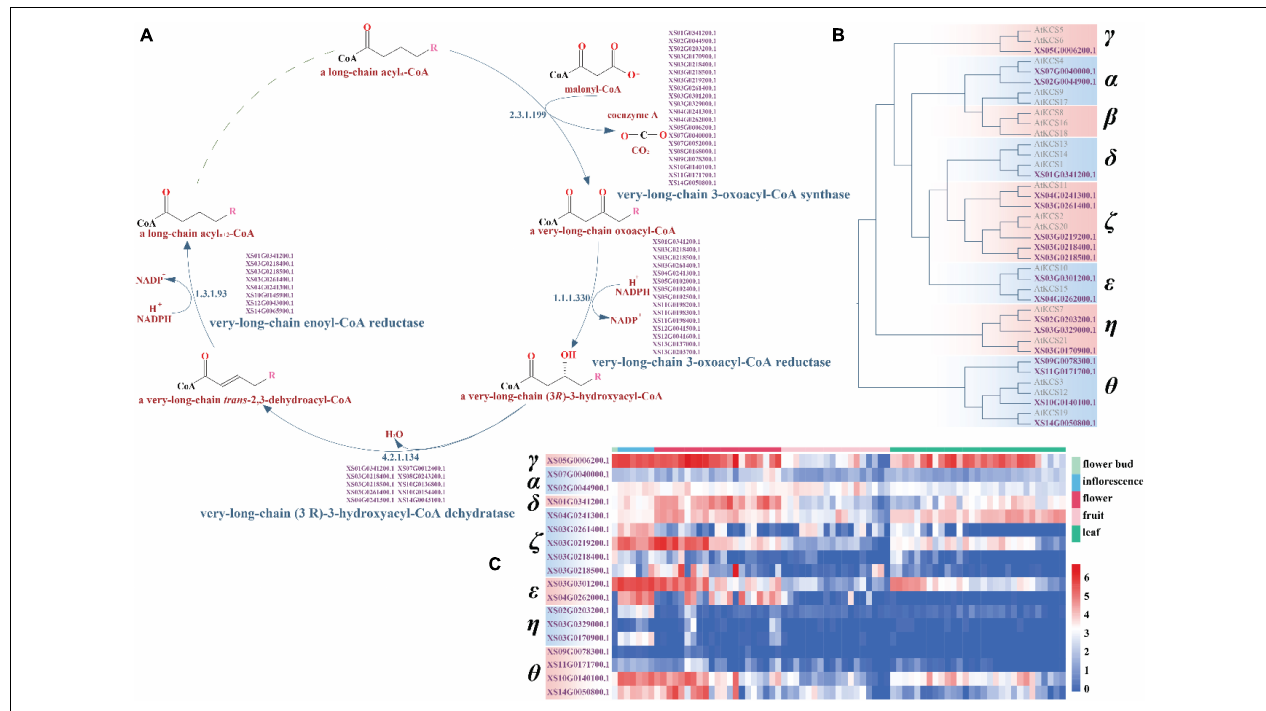
FIGURE 5 | The very-long-chain fatty acid biosynthesis pathway and the classification and expression profile of the candidate KCS genes. (A) The candidate genes-encoding key enzymes in the four reactions of the very long-chain fatty acid synthesis pathway in yellowhorn genome. (B) Phylogenetic tree of the candidate KCS genes in Arabidopsis and yellowhorn. (C) The candidate KCS genes expression profile. The expression values were normalized by ln (TPM + 1).